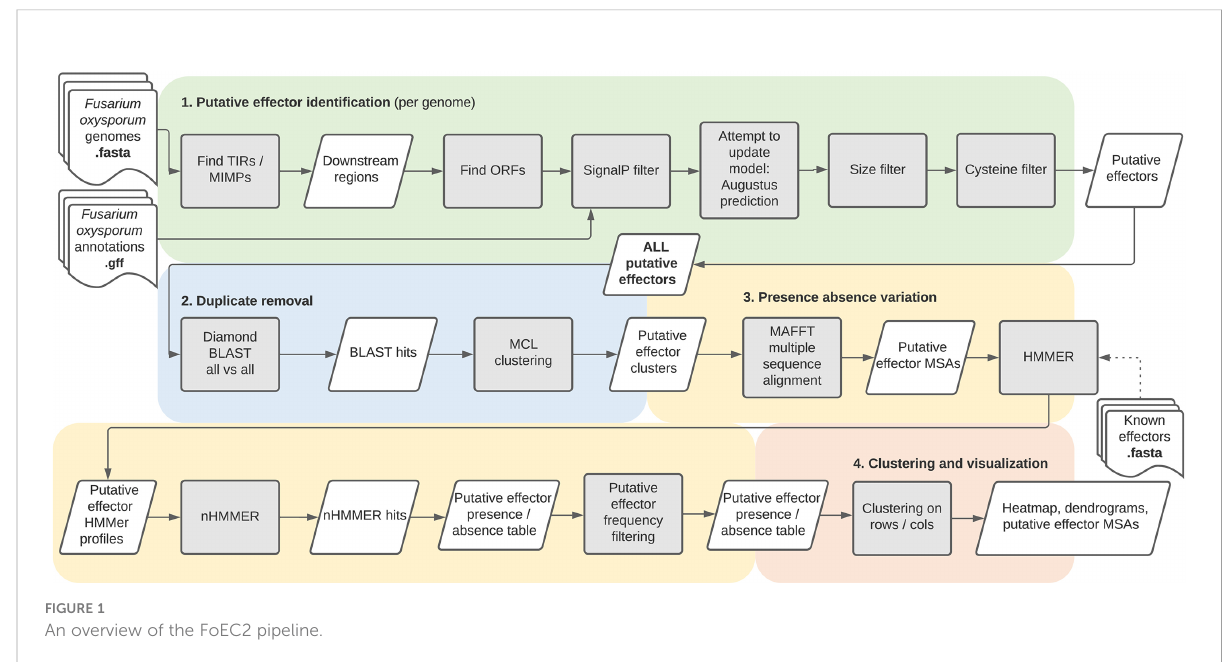
FIGURE 1 An overview of the FoEC2